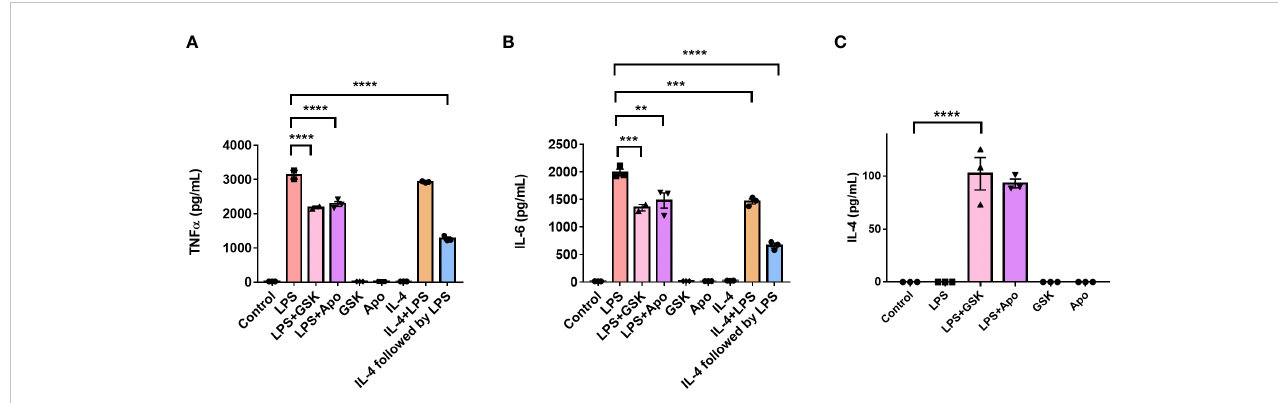
FIGURE 8 NOX2 inhibition affects the levels of in fl ammation associated cytokines in mouse bone marrow-derived macrophages. (A) TNF- a and (B) IL-6 (pro- in fl ammatory cytokines), and (C) IL-4 (anti-in fl ammatory cytokine) levels in BMDMs (n = 3) with and without LPS and NOX2 inhibitors apocynin and GSK2795039 measured using ELISA. Based on ELISA data, we did not see any IL-4 secretion from BV2 microglia. This could be because of the immortalization process. Data are represented as mean ± SEM and analyzed using single-factor ANOVA test. ** denotes p < 0.01, *** denotes p < 0.001 and **** denotes p <